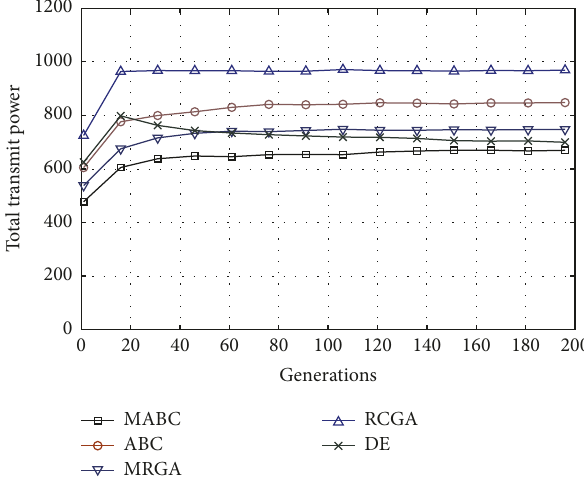
Figure 7: The total transmitting power towards a generation.